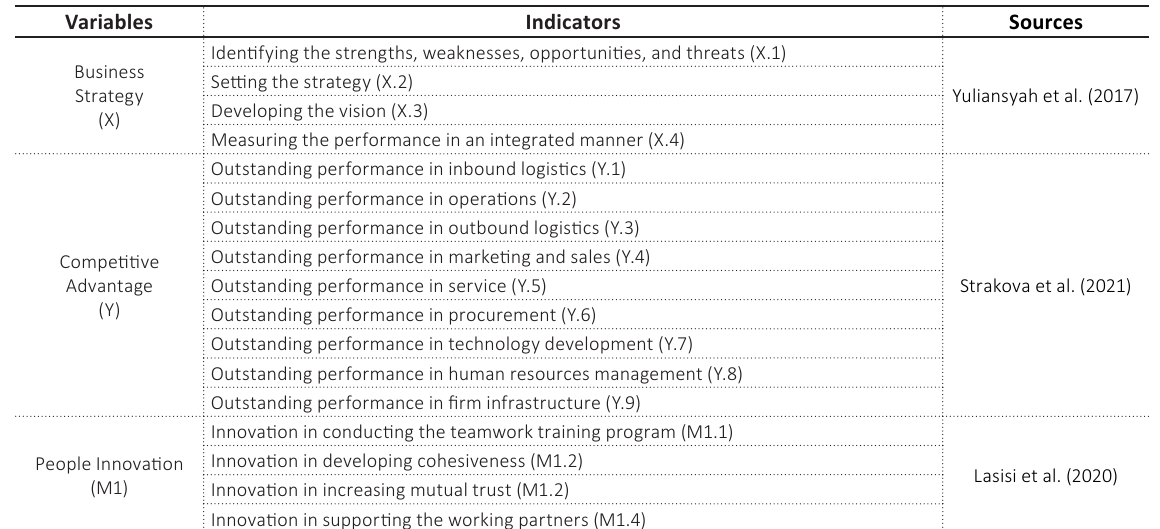
Table 1. Research variables and